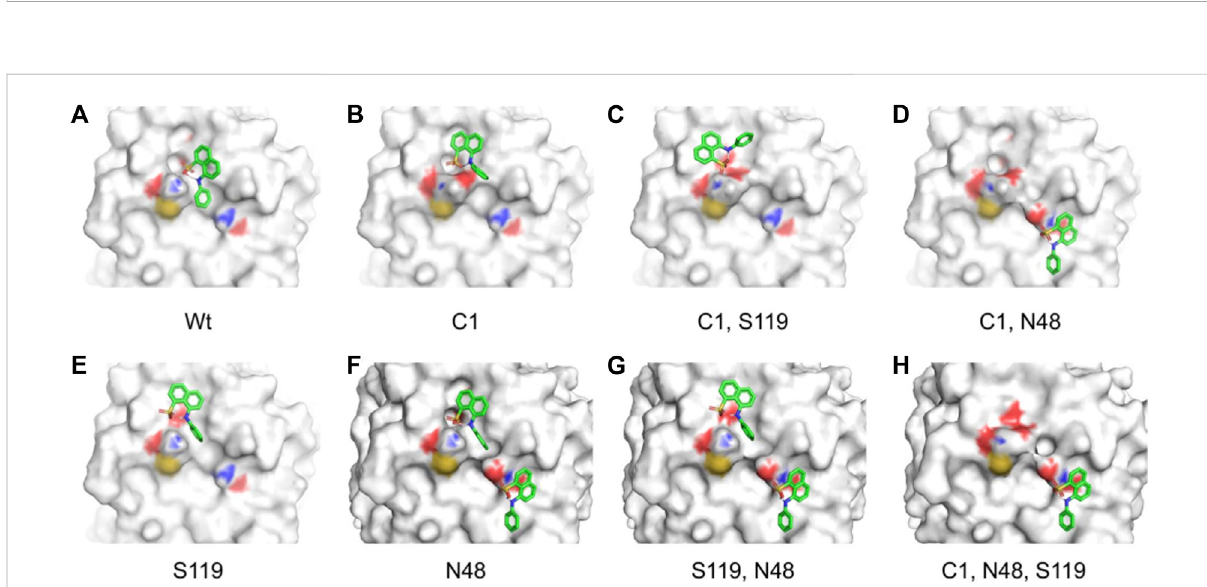
FIGURE 9 Different binding modes of ANS with CHT (external site) as obtained by molecular docking simulation. (A – H) Best binding modes of ANS on residuemodi fi cation[Cys-1;Asn-48;Ser-119]asmentionedpreviously;extensivechangeinbindingmodesresultinginheterogeneityofANSbinding is